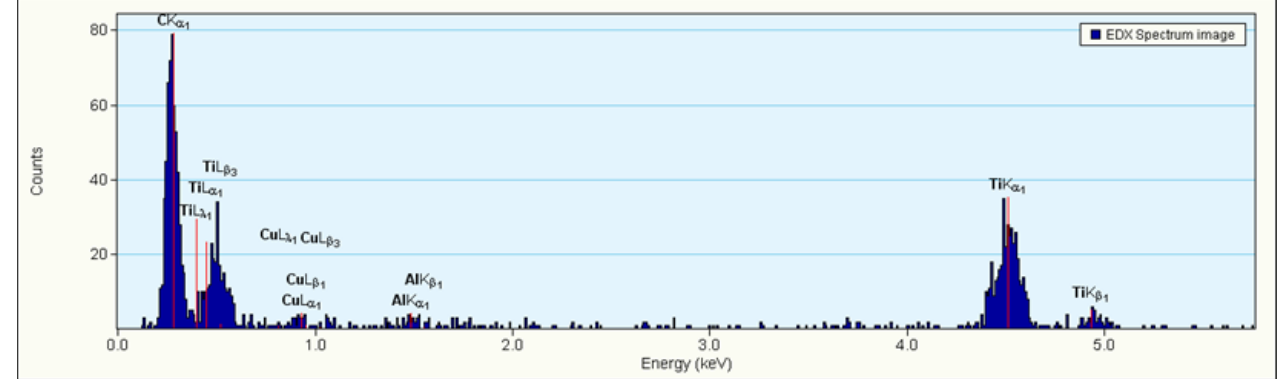
Figure 4. EDS spectra acquired from the fragment of the whisker sticking-out from the surface TiN layer grown on PN Ti-6Al-7Nb alloy.